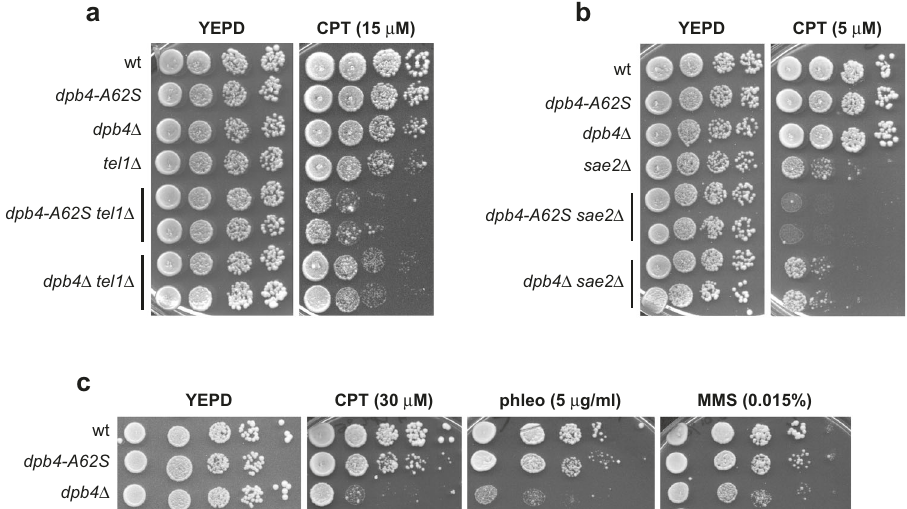
Fig. 1 The dpb4-A62S mutation exacerbates the CPT sensitivity of tel1 Δ and sae2 Δ cells. a – c Exponentially growing cell cultures with the indicated genotypes were serially diluted (1:10) and each dilution was spotted out onto YEPD plates with or without camptothecin (CPT), phleomycin (phleo), or methyl methanesulfonate (MMS) at the indicated